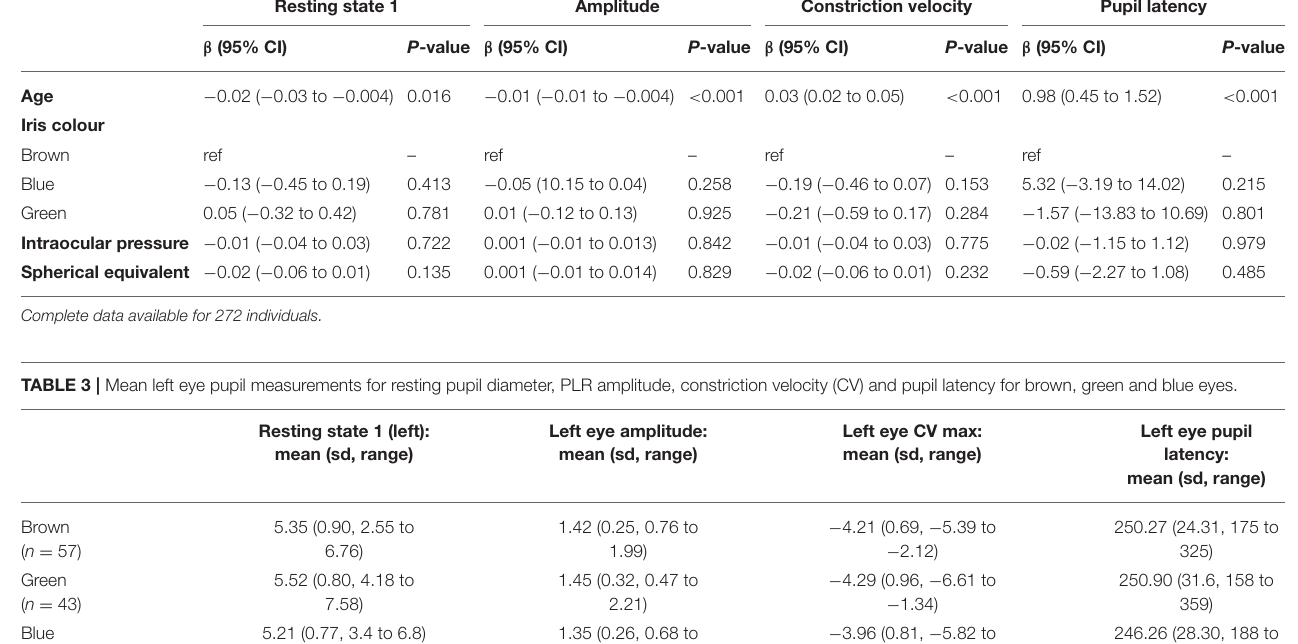
TABLE 2 | Multivariable linear regression models examining the association of age, iris colour, intraocular pressure and spherical equivalent on pupil characteristics in the left eye, adjusted for family structure. Resting state 1